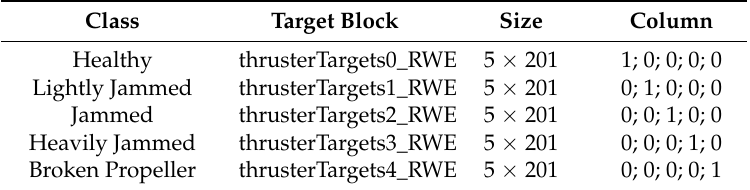
Table 7. Structure of the output training data set thrusterTargets_RWE.